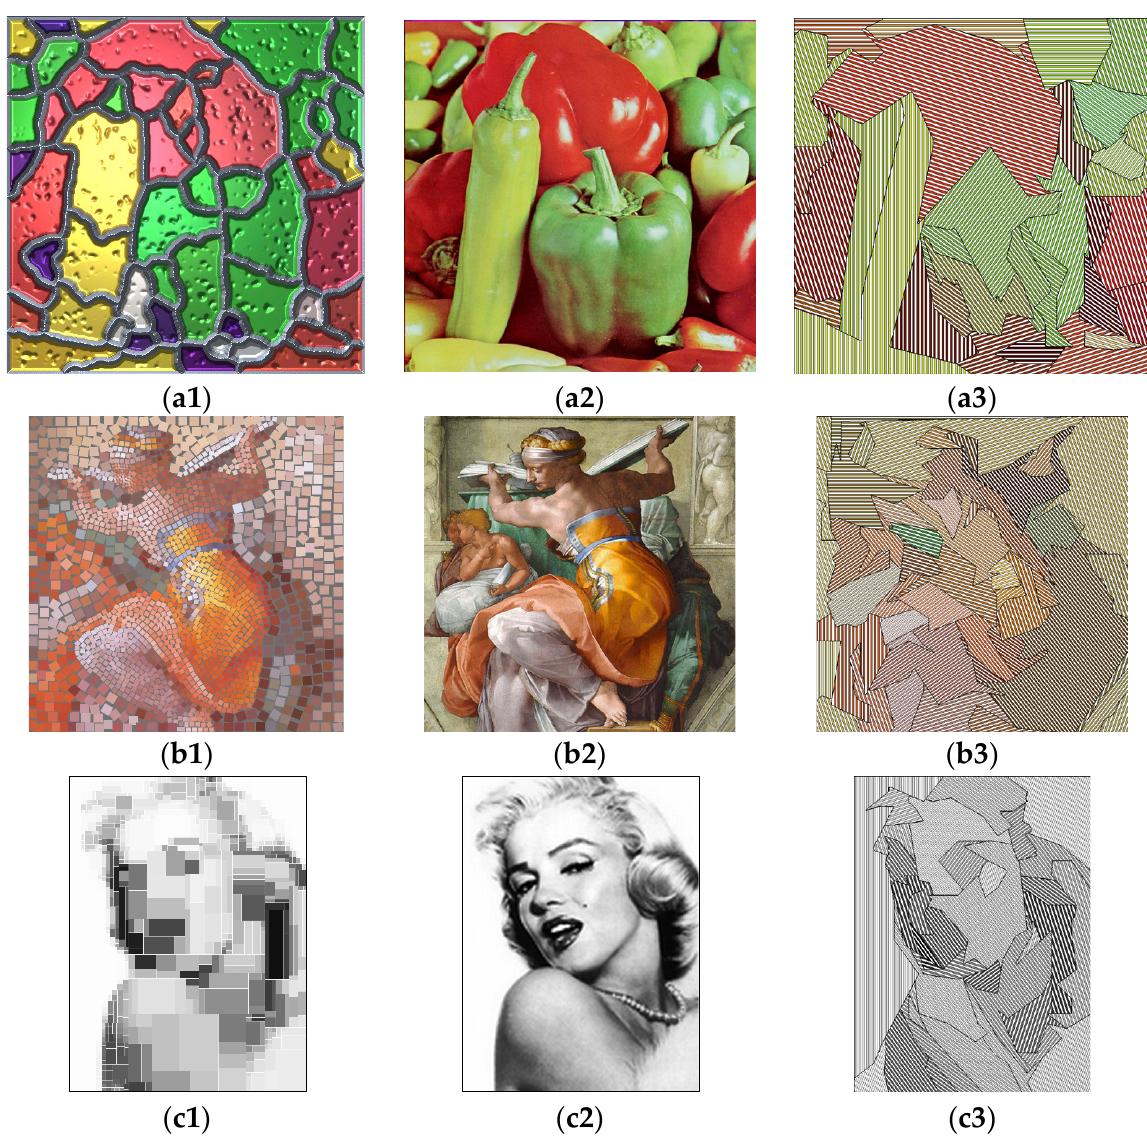
Figure 22. Stripe-based Futurism-like images generated in this study using the images in Figure 2 as inputs. ( a1 – a3 ) A stained-glass-like image created by Mould [3], the corresponding original im- age, and the stripe-based Futurism-like image generated by the proposed algorithm (Algorithm 1). ( b1 – b3 ) A tile-mosaic-like image created by Hausner [4], the corresponding original image, and the stripe-based Futurism-like image generated by the proposed algorithm (Algorithm 1). ( c1 – c3 ) A rectangle-based Neo-Plasticism-like image created by Liu et al. [5], the corresponding original im- age, and the stripe-based Futurism-like image generated by the proposed algorithm (Algorithm 1).